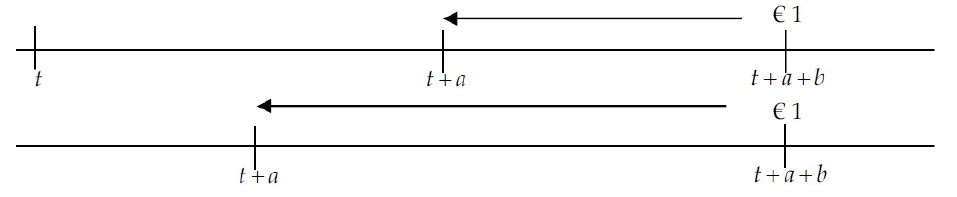
Figure 5. Subadditivity in a dynamic situation. Source: Own elaboration.